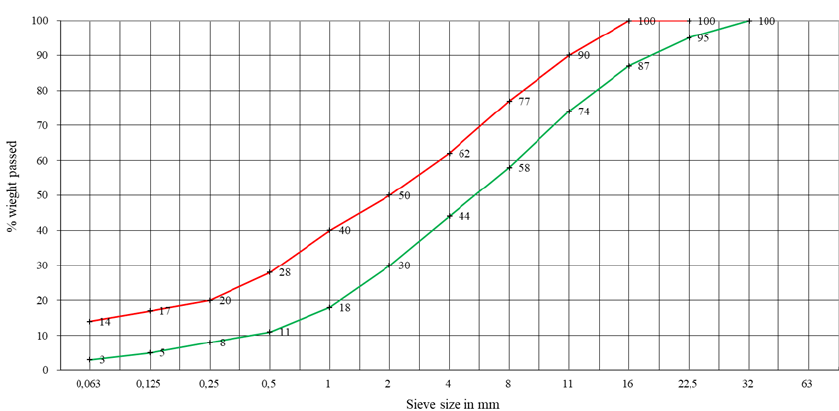
Figure 1. Stress diagram of a strengthened beam. Source: Adapted from Silveira [4].